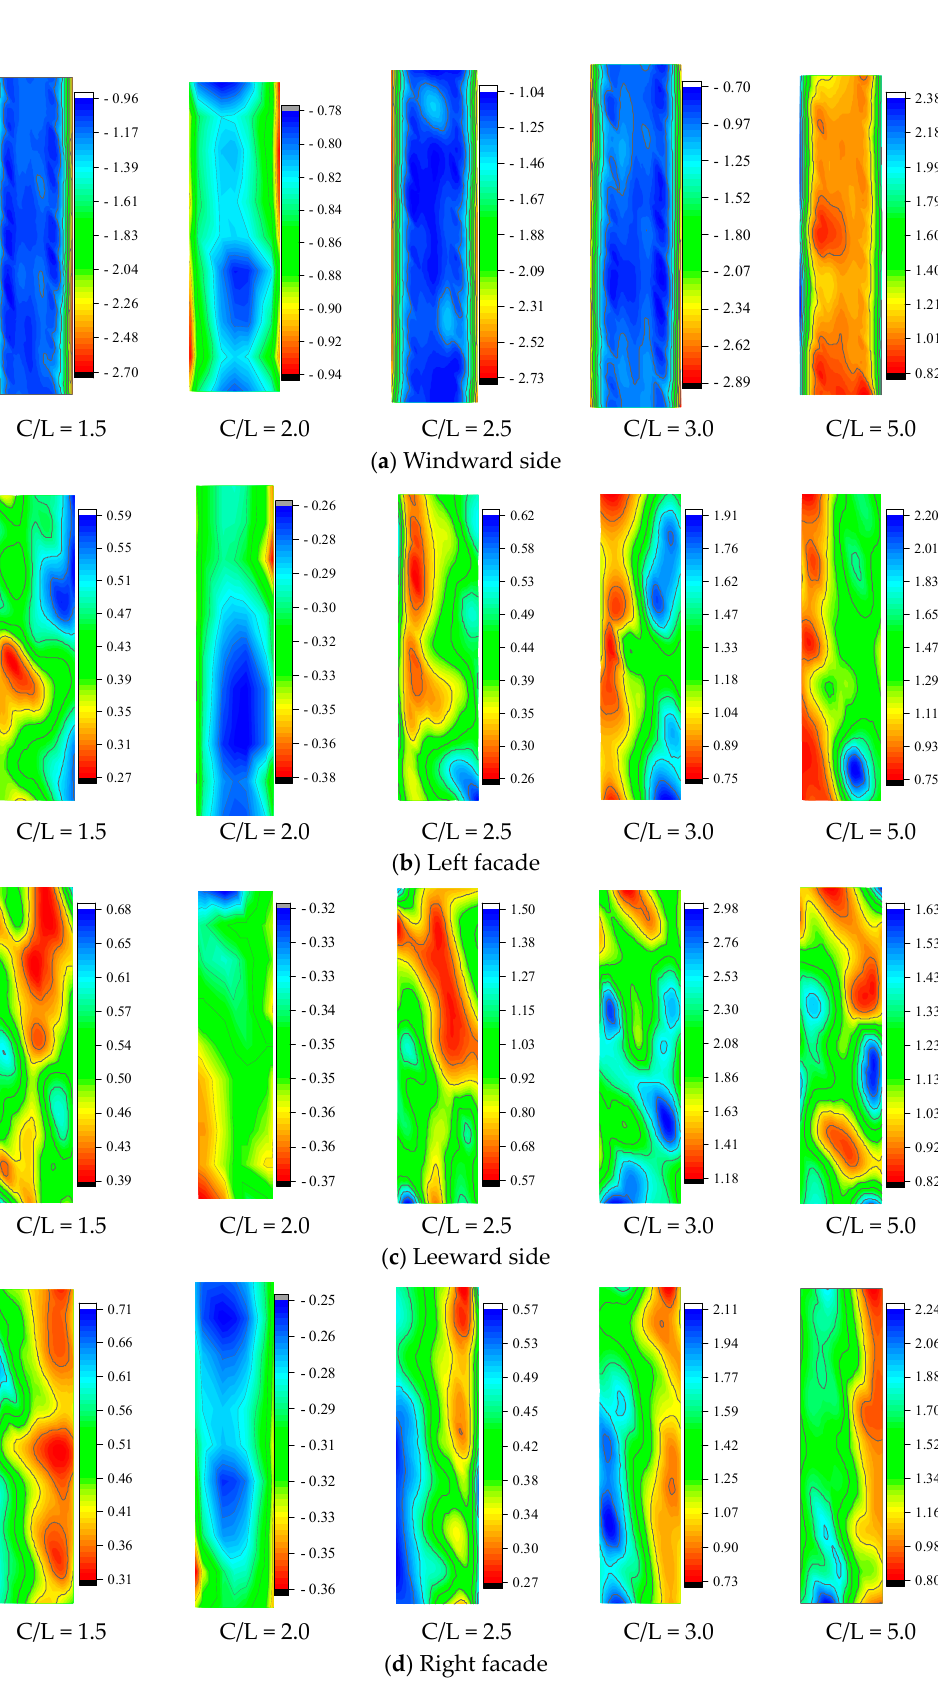
Figure 14. IF contours of square cylinders .